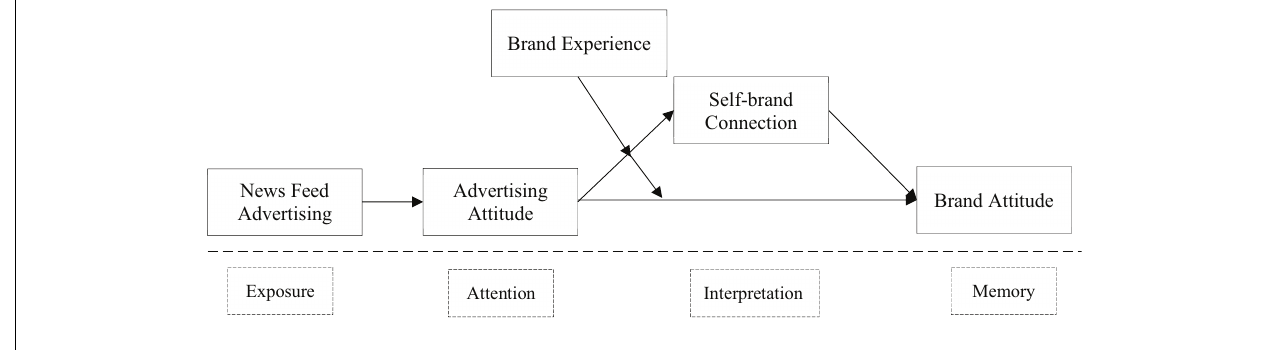
FIGURE 1 | Theoretical